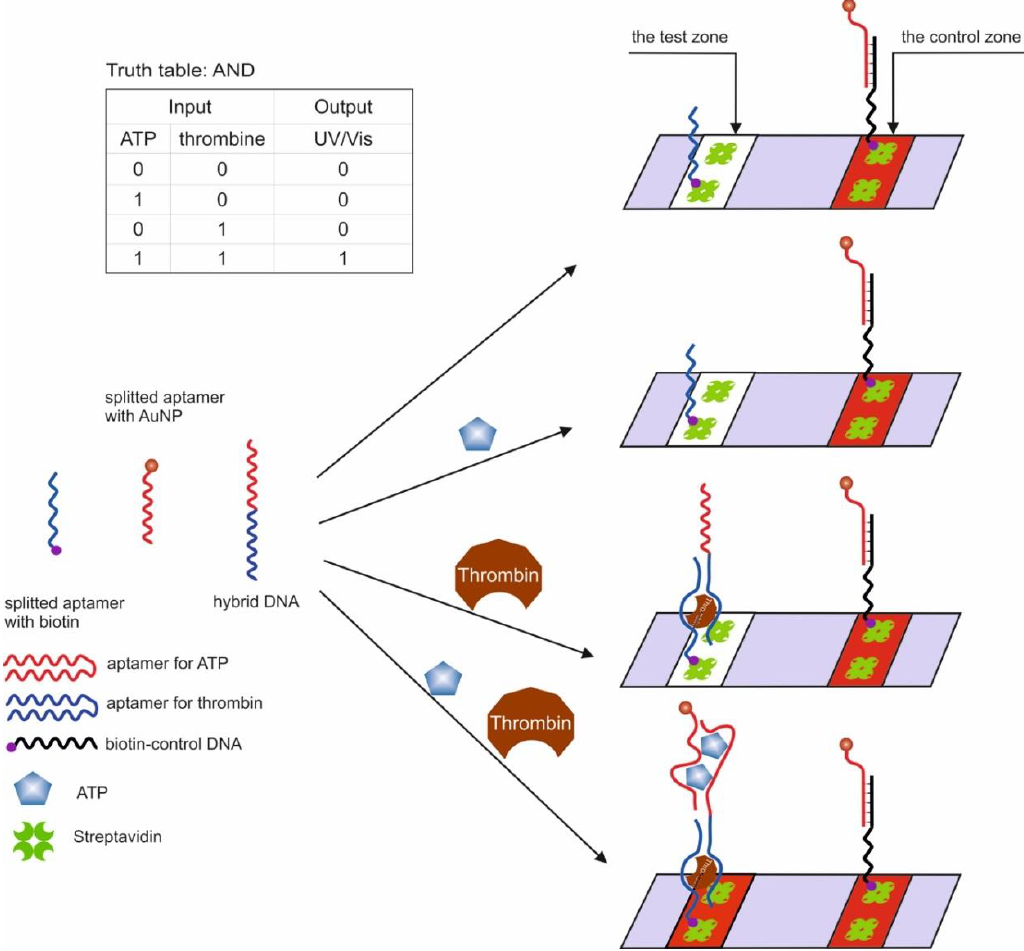
Figure 5. The AND logic gate. ATP = adenosine triphosphate. Adapted from Reference [54]. Copyright © 2020, American Chemical Society.